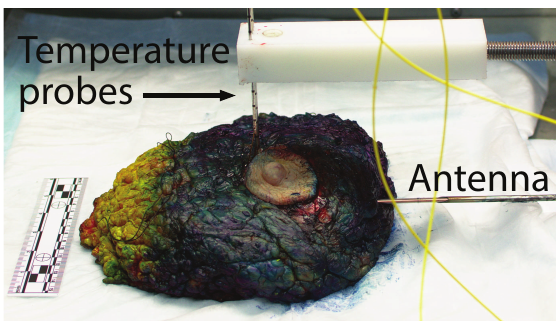
Figure 2. Photograph of the microwave ablation and temperature monitoring configuration. The rigid ablation antenna is inserted horizontally into the mastectomy specimen, while four fiber-optic temperature probes are inserted vertically into the tissue through biopsy needles. The yellow and dark blue color of the specimen is due to ink applied to the specimen surface as part of the standard pathology grossing